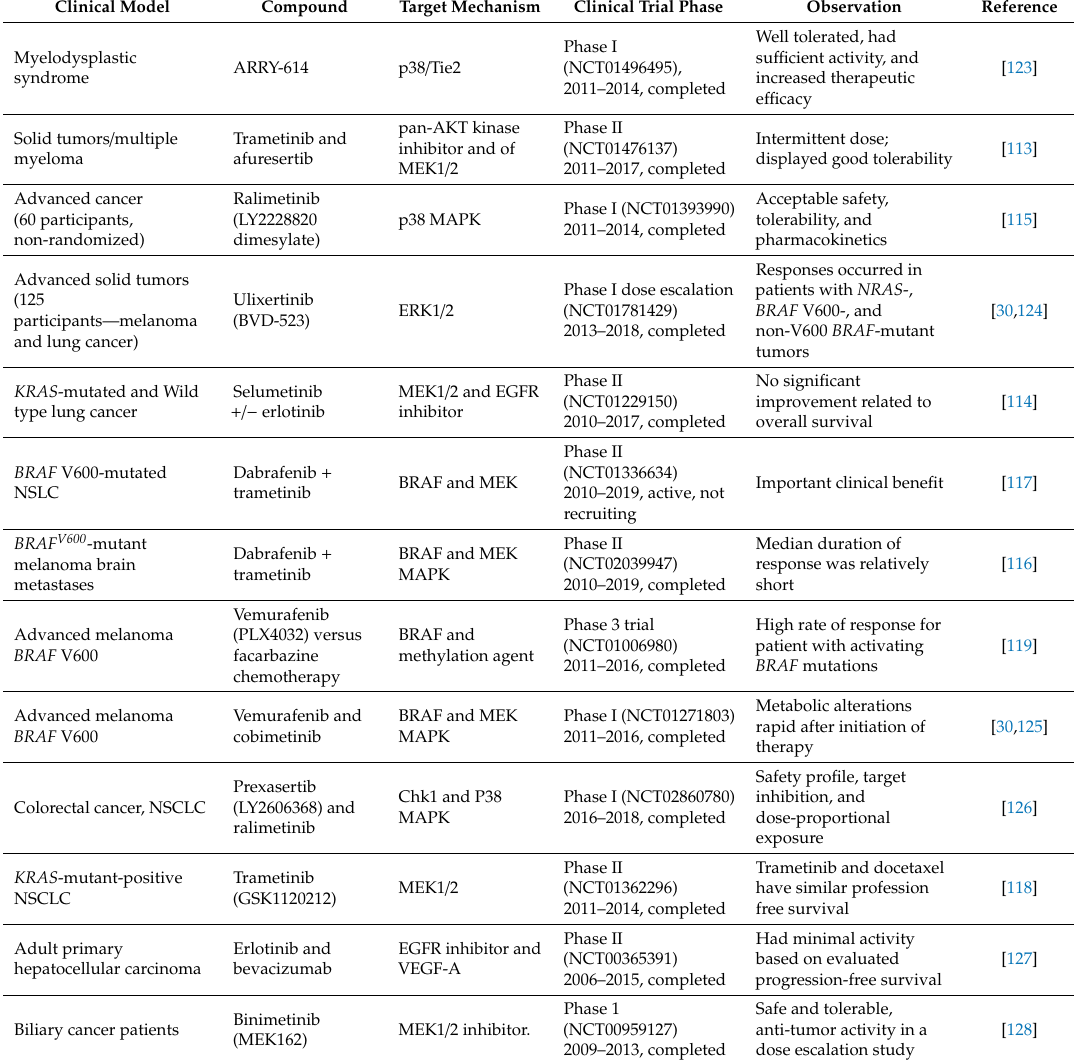
Table 3. Some relevant examples of application of MAPK in clinical